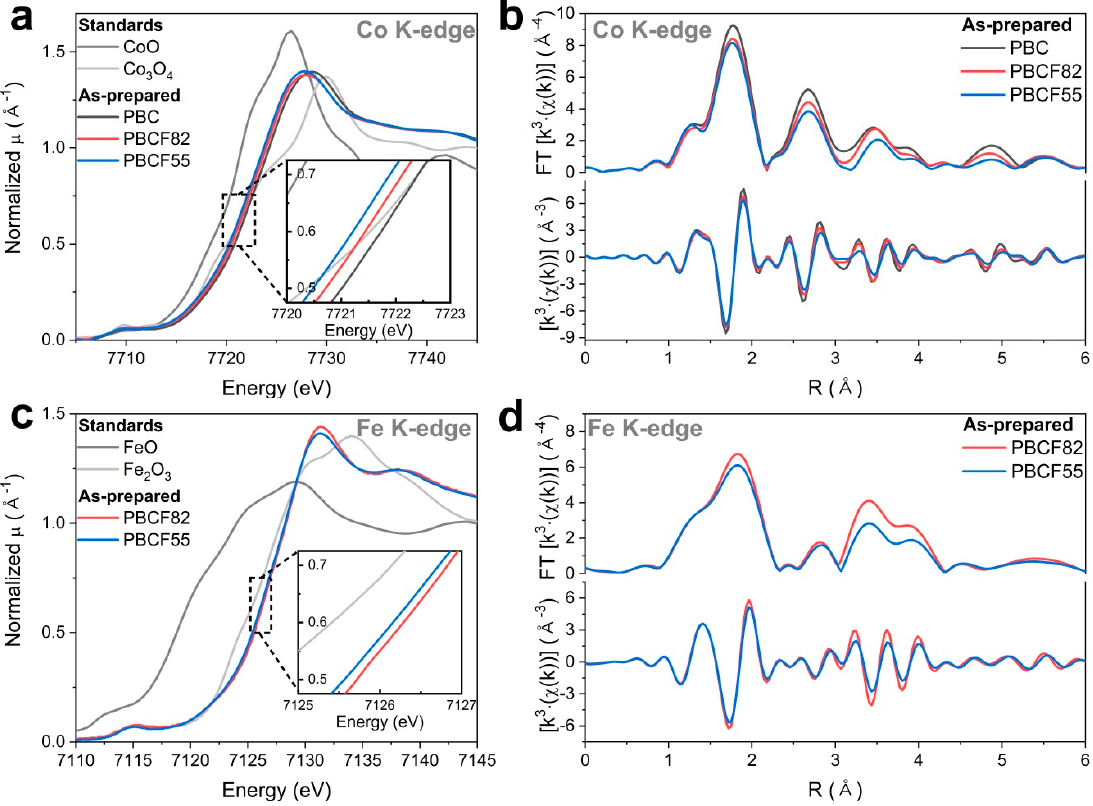
Figure 4. Comparison of as-prepared PBC, PBCF82, and PBCF55 Co K-edge ( a ) X-ray absorption near edge spectra (XANES) spectra; ( b ) Fourtier-transformed extended X-ray absorption fine structure (FT-EXAFS) spectra; and Fe K-edge; ( c ) XANES spectra; and ( d ) FT-EXAFS spectra.